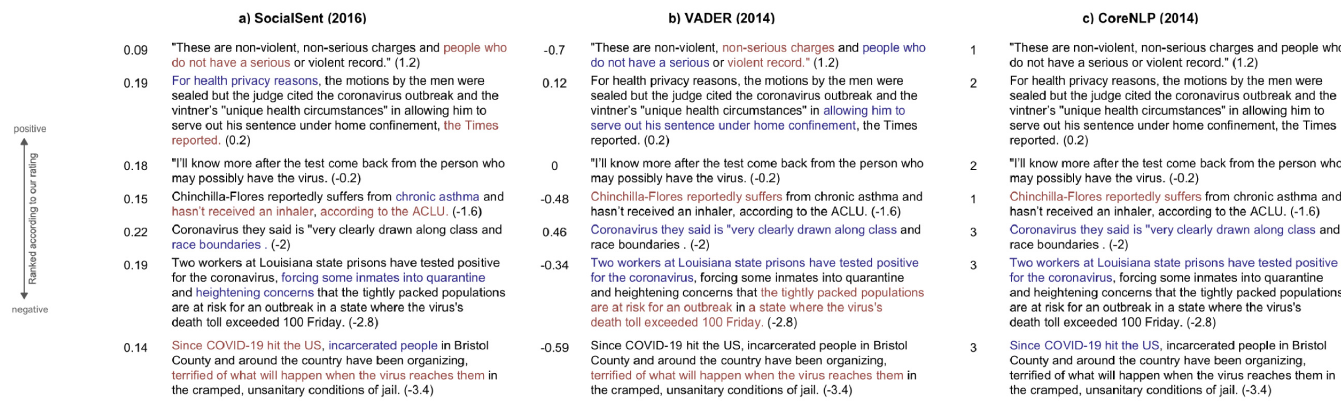
Fig 1. Standardized sentence sentiment scores that deviated least from manually-curated scores, exemplified by three distinct SA packages. SocialSent was considered because it is specifically attuned to social science contexts. VADER was also included for comparison because it is one of the most widely used SA packages. Finally, CoreNLP was used due to its accuracy in sentiment scoring by a recent systematic review of SA in public health. The sentences are arranged from top to bottom in order of most positive sentiment score to most negative, as determined by manual curators. The left, middle, and right panels correspond with the SocialSent, VADER, and Stanford CoreNLP SA packages, respectively. To the left of the sentences are the sentiment values assigned by each SA package on its own scale (SocialSent from 0 to 1, VADER from -1 to 1, CoreNLP 1 to 3); our ratings follow each sentence in parentheses (range of -4 to 4). Colors indicate relative sentiment associated with the selected portion of the sentence, with red and blue indicating negative and positive sentiment, respectively, as determined by running each algorithm on separate phrases within the sentences.